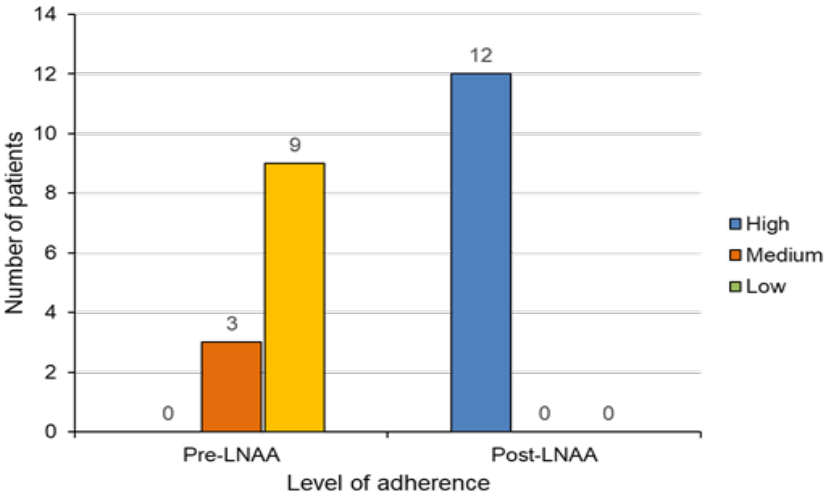
Figure 1. Patients’ subjective assessment of the level of therapy adherence over the past 4 Figure 1. Patients' subjective assessment of the level of therapy adherence over the past 4 weeks.